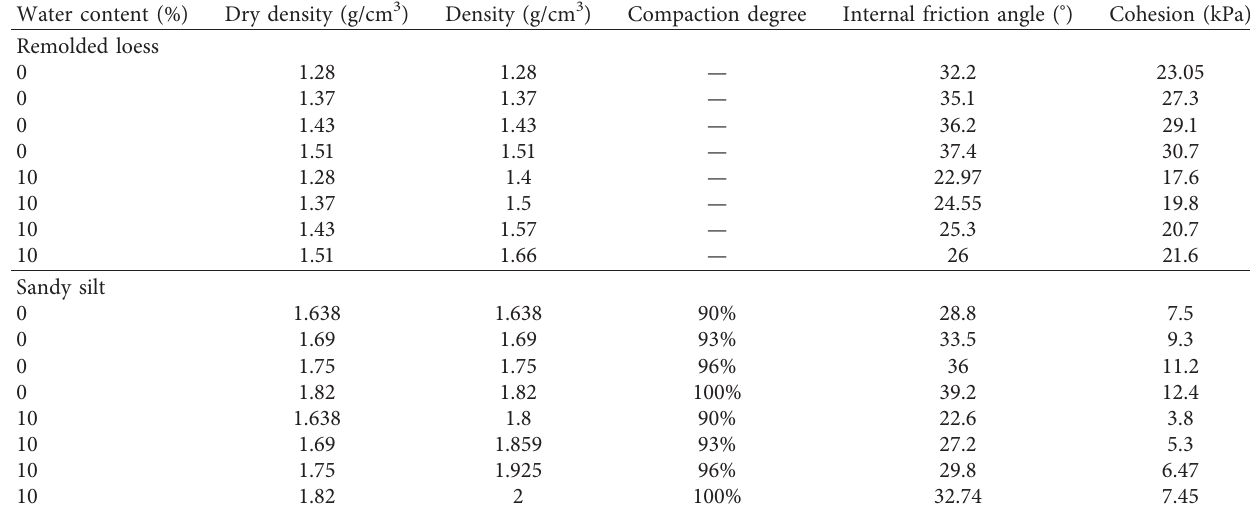
Table 3: Properties of the remolded loess, sandy silt, and direct shear test results.